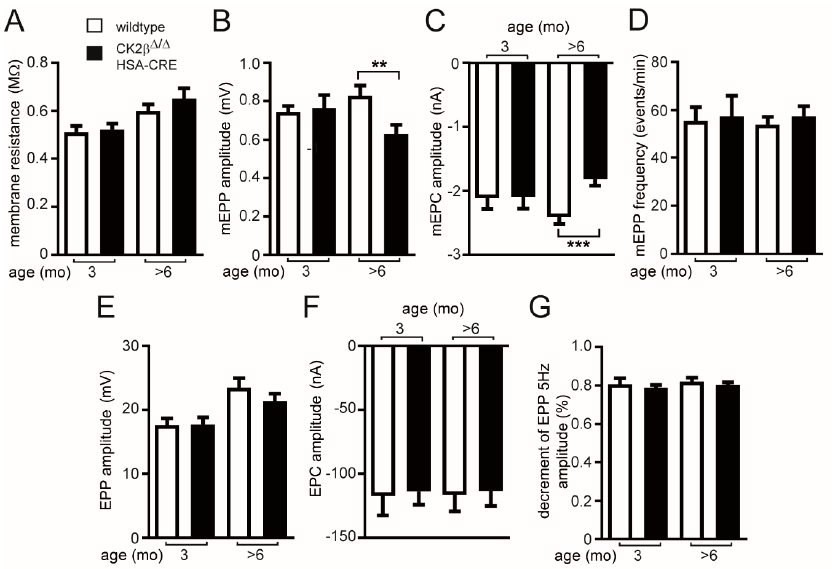
Figure 1. In >6-months-old mice but not 3-months-old mice, conditional CK2 β -deficient mice exhibited impairment of neural transmission, as reflected by lowered miniature endplate potentials and currents in comparison with wild-type litters. The following electrophysiological recordings are presented: ( A ) membrane resistance, ( B ) miniature endplate potential amplitudes, ( C ) miniature endplate current amplitudes, ( D ) frequency of miniature endplates, ( E ) endplate potential amplitudes, ( F )